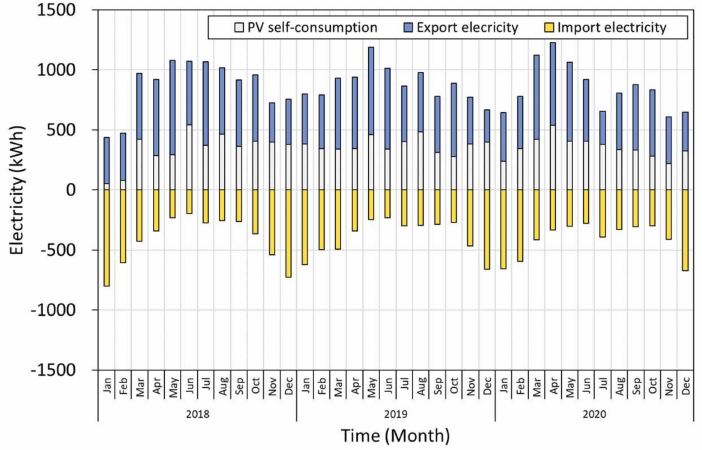
Figure 6. Monthly consumption and generation distribution in Gongam house.